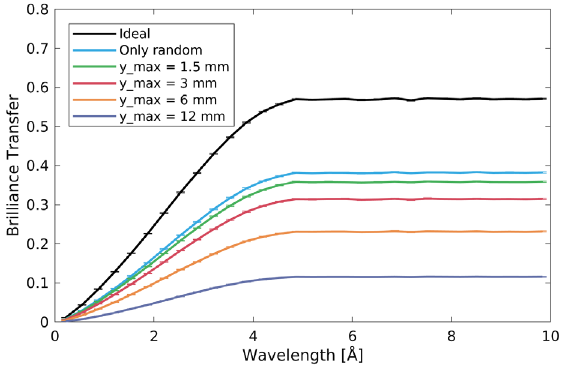
FIG. 5. Brilliance transfer as a function of wavelength for a straight guide with displacement model 1.